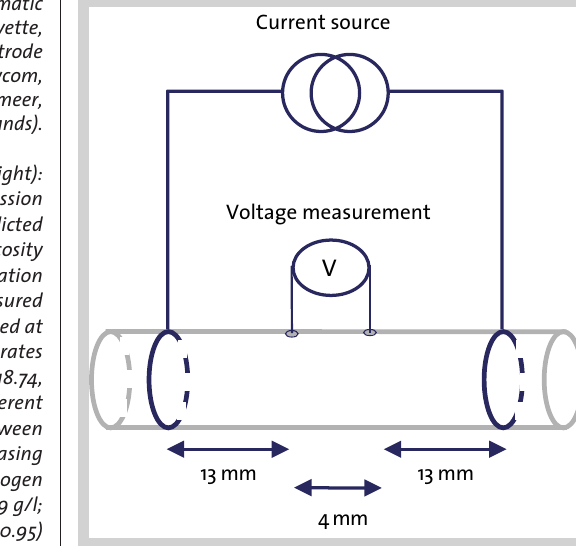
Figure 2 (left): Schematic design of the Rho-cuvette, and the four-electrode positioning (Cd-Leycom, Zoetermeer, The